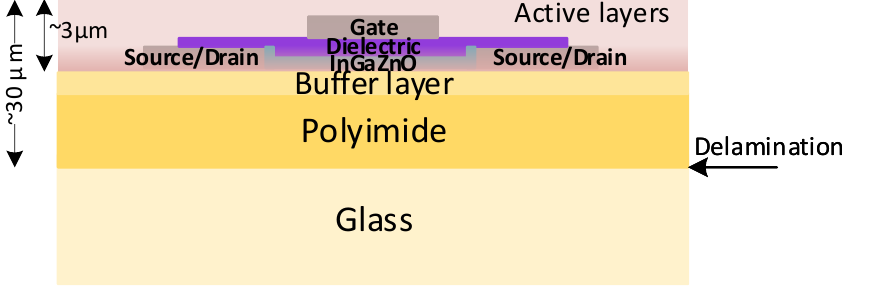
Figure 1. Schematic diagram of the IGZO structure stack